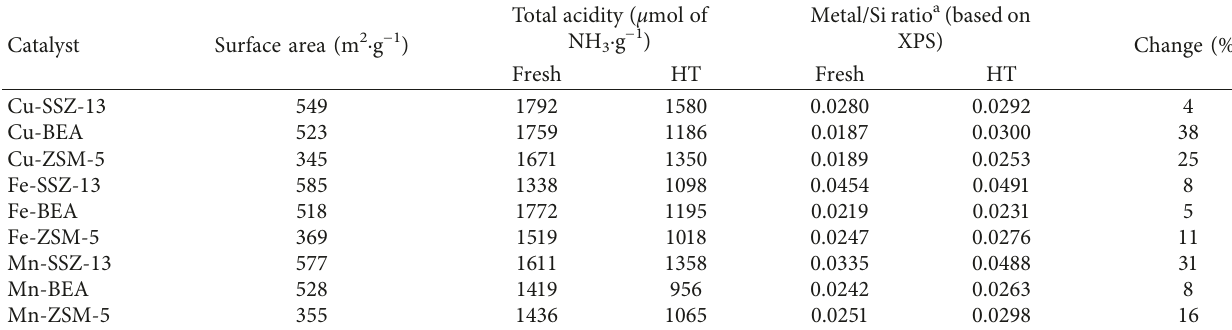
Table 2: Physical characterization of catalysts.